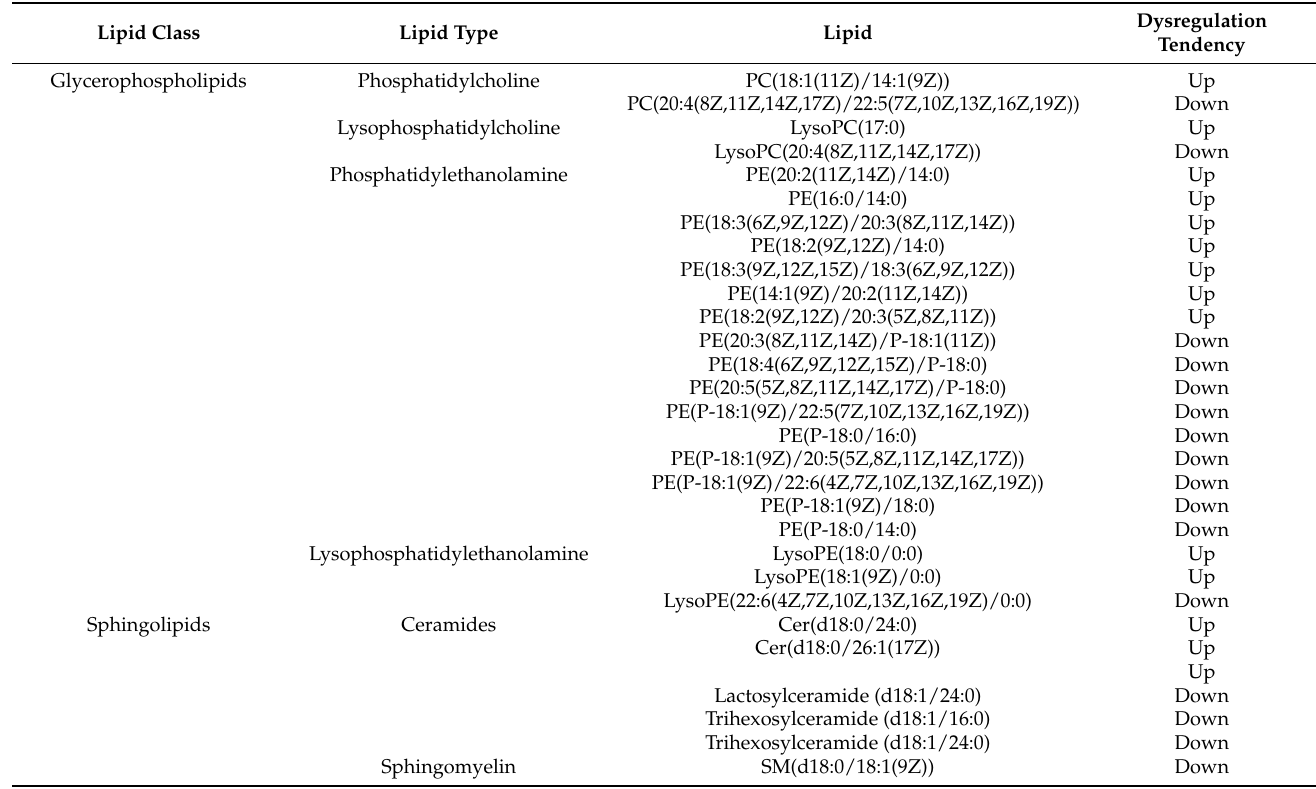
Figure 3. Volcano plot of MCF-7 vs. MDA-MB-231. 143 compounds are differentially found between both cell lines. The figure shows significant upregulated (red) and downregulated (blue) features ( p -value ≤ 0.01); features that did not meet fold change or p -value are shown in gray. Table 1. Identified compounds found with differential fold change by compound type and class of MCF-7 vs. MDA-MB-231.